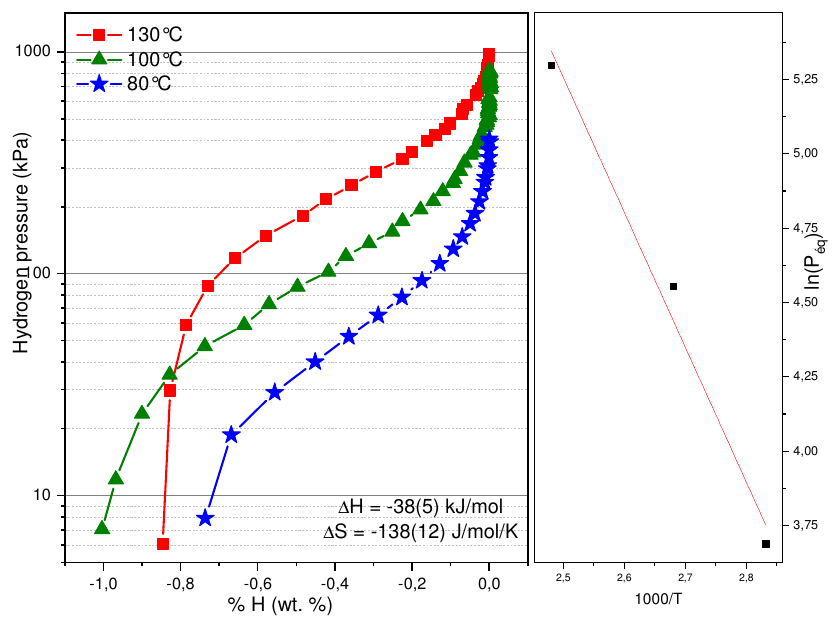
Figure 10. Desorption PCTs at 80, 100, and 130 °C and ln (Peq) vs. (1000/T) of the co-melt Ti 1.26 V 0.315 (FeV) 0.315 Cr 1.11 + 4% Zr 7 Ni 10 .